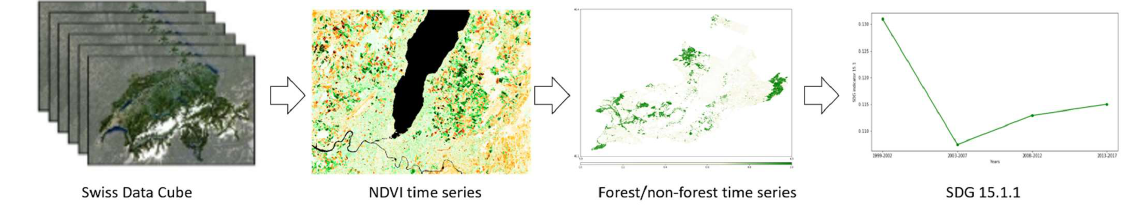
Figure 1. General overview of the analysis workflow.